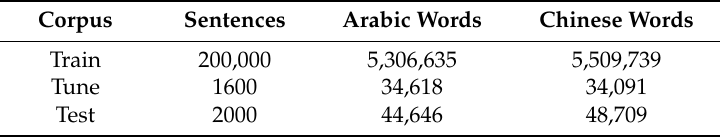
Table 2. Statistics of the Arabic-Chinese parallel corpus. For Chinese, size refers to the segmented